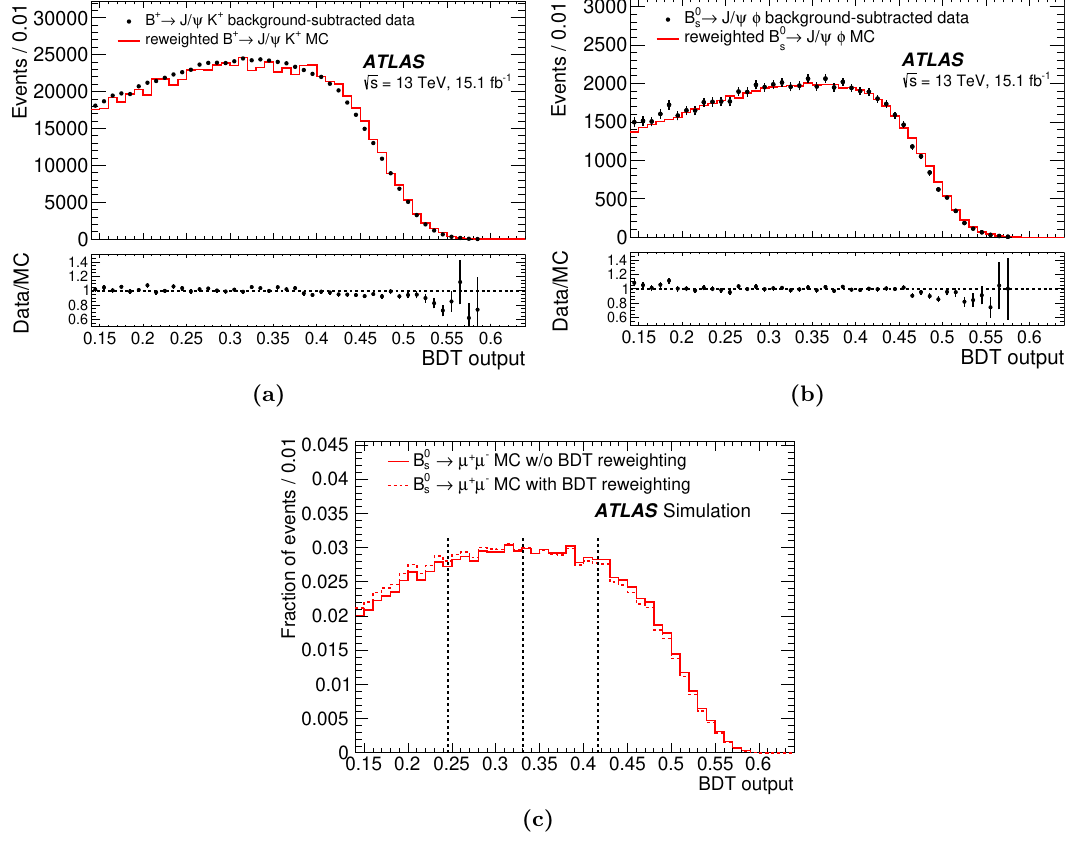
Figure 7. BDT value distributions in data and MC simulation for (a) B + ! J= K + , (b) B 0 ! J= (cid:30) . The MC samples are normalised to the number of data events passing the signal s reference BDT selection (section 6). Figure (c) illustrates the BDT output for the B 0 signal, with the dashed histogram illustrating the e(cid:11)ect of the linear reweighting on the BDT output discussed in the text. The vertical dashed lines correspond to the boundaries of the BDT intervals used in the B 0 ! (cid:22) + (cid:22) (cid:0) signal ( s )